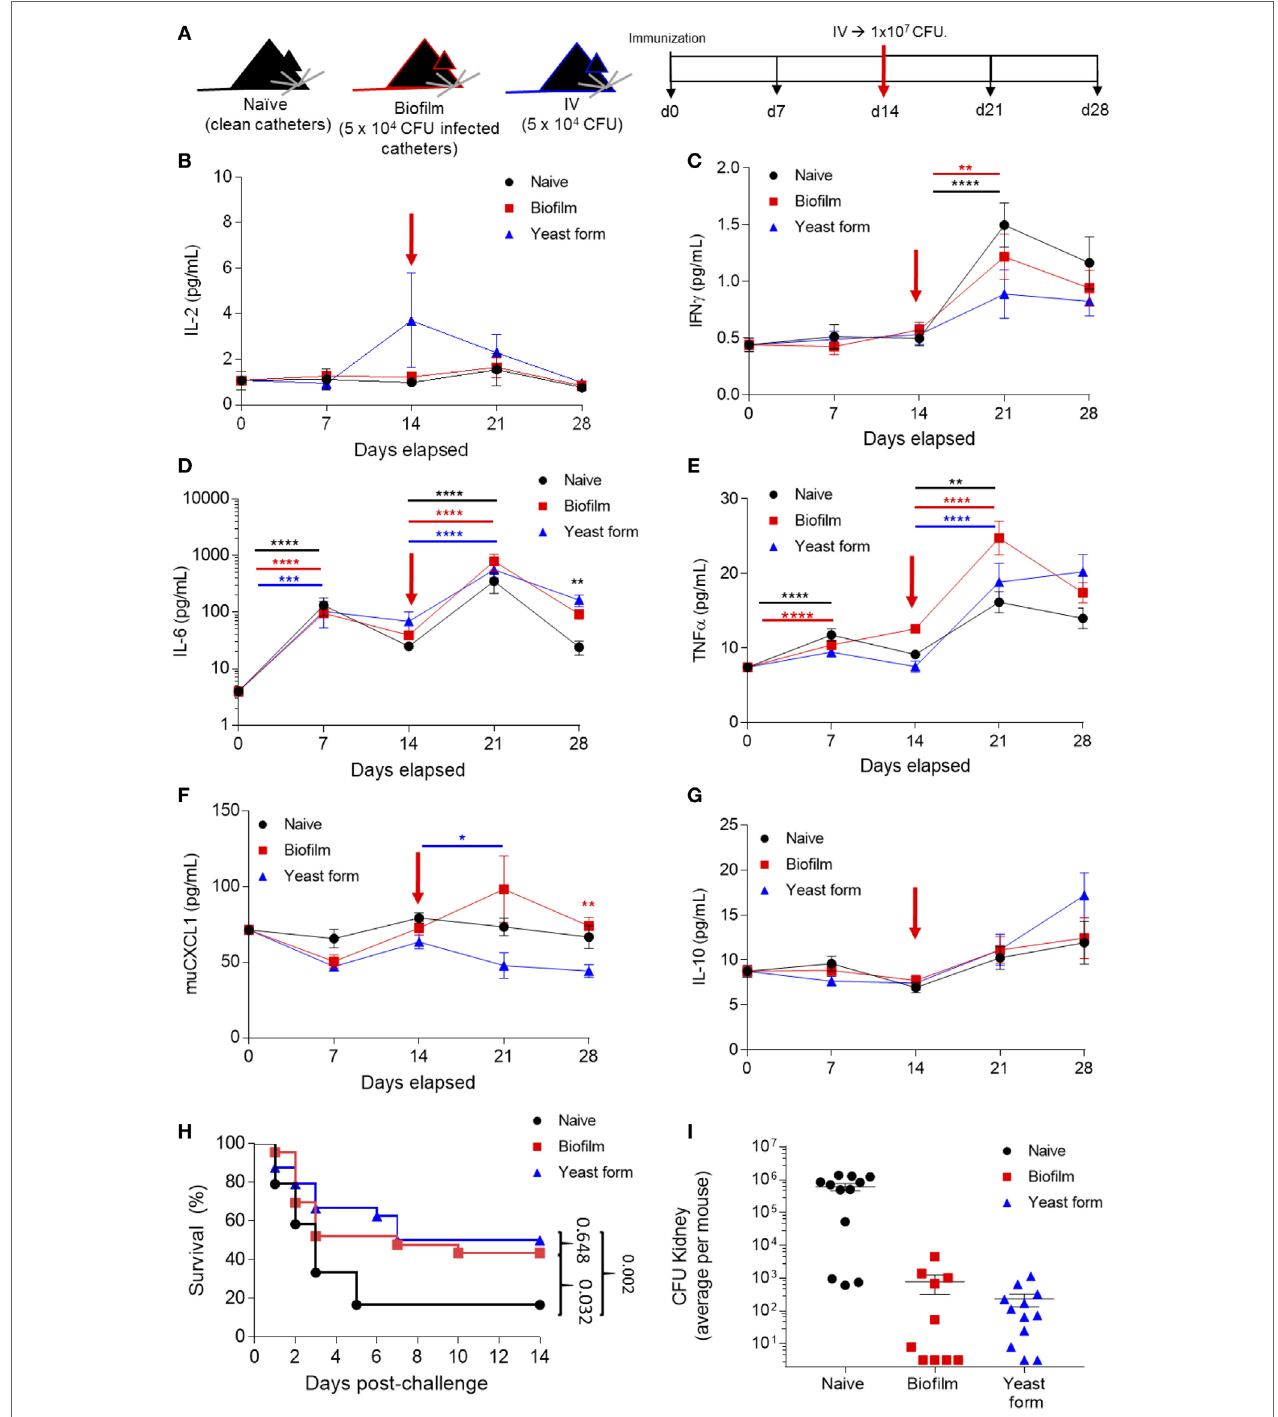
FigUre 3 | Candida albicans biofilm promotes sterilizing immunity against infection lethal dose of yeast form C. albicans . (A) Mice were surgically implanted with sterile catheters (“naïve” group, n = 24), with catheters seeded with 5 × 10 4 Candida for biofilm growth (“biofilm immunized” group, n = 25) or i.v. injected with 5 × 10 4 Candida (“yeast-form immunized” group, n = 25) on day 0. On day 14, each group was challenged with a 10 7 colony forming unit (CFU) Candida i.v. Mice were monitored for cytokine expression on days 0, 7, 14, 21, and 28. (B) Serum samples from all the time points were analyzed for IL-2, (c) IFN γ , (D) IL-6, (e) TNF α , (F) muCXCL1, and (g) IL-10. Kruskal–Wallis test was used to compare the different groups at the same time point and to different time points. Average ± SEM. (H) Survival of all mice groups post high-dose challenge (1 × 10 7 CFU). (i) Kidney colonization, showing the average count (Log 10 CFU) per mouse on both kidneys after high-dose challenge for naïve mice (date of death, n = 12), biofilm immunized mice ( n = 10, day 14 post-challenge), and yeast-form immunized mice ( n = 12, day 14 post-challenge). Cytokine and survival data are pooled from two independent experiments (** p < 0.005, *** p < 0.0001, and **** p < 0.00001).